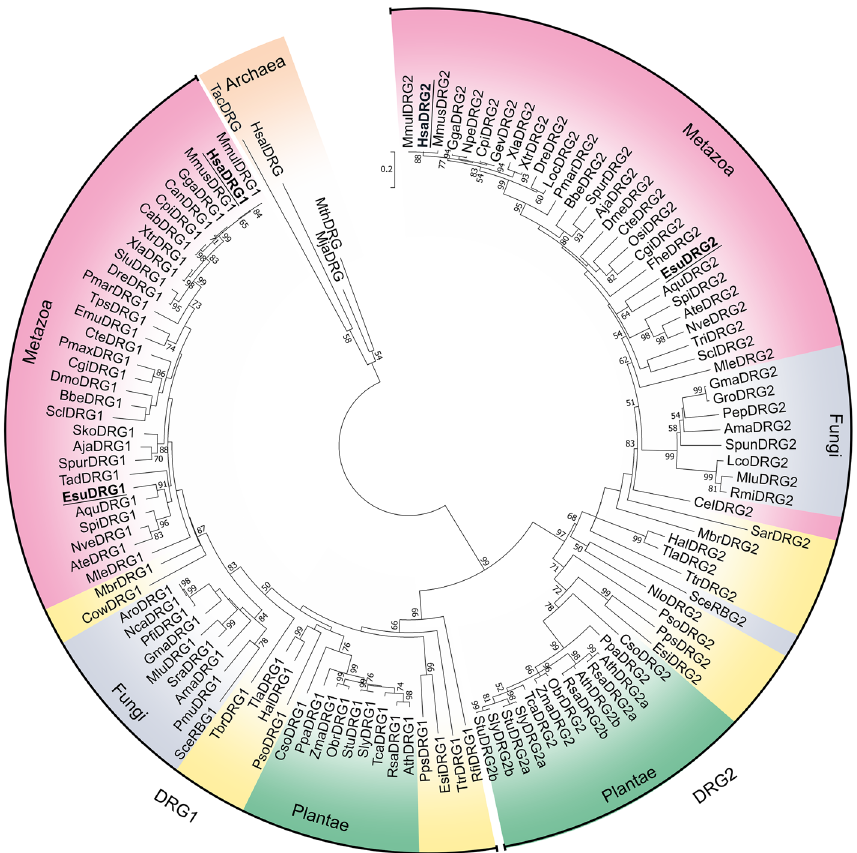
Figure 1. Phylogenetic relationships of DRG subfamily proteins in archaea and eukaryotes. The phylogenetic tree was rooted with archaeal DRG proteins as the outgroup. The numbers associated with branches are ML amino acid sequences involved are listed in Supplementary Table S2. Taxonomic groups are highlighted in the following colors: Metazoa in pink, Fungi in grey, Plantae in green, Protista in yellow and Archaea in